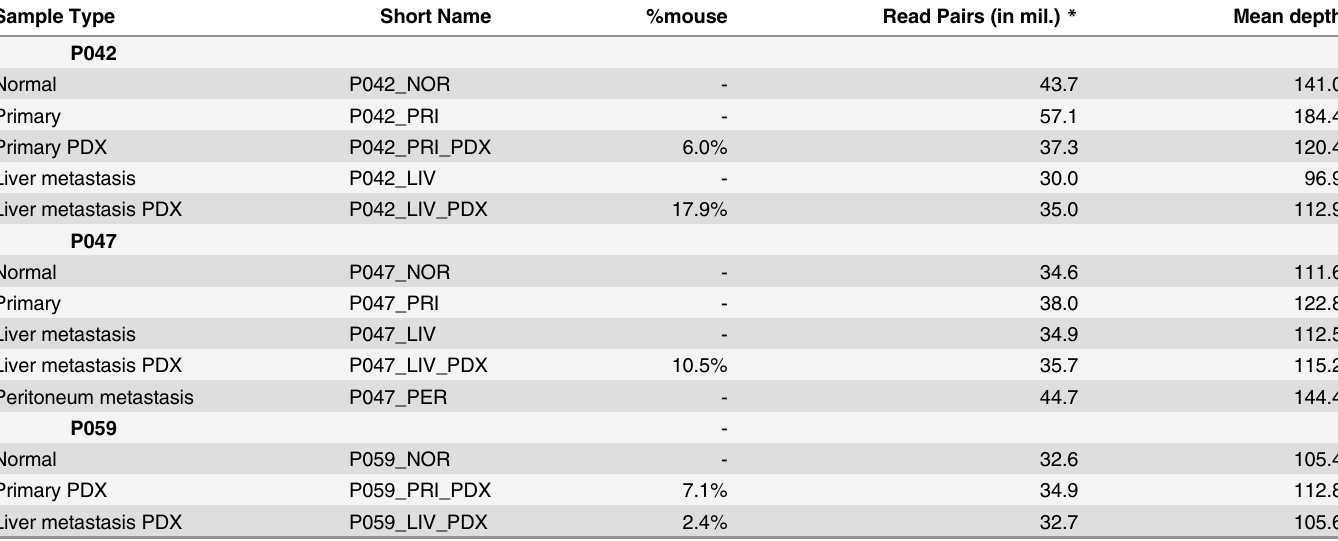
Table 1. Summary statistics of WES